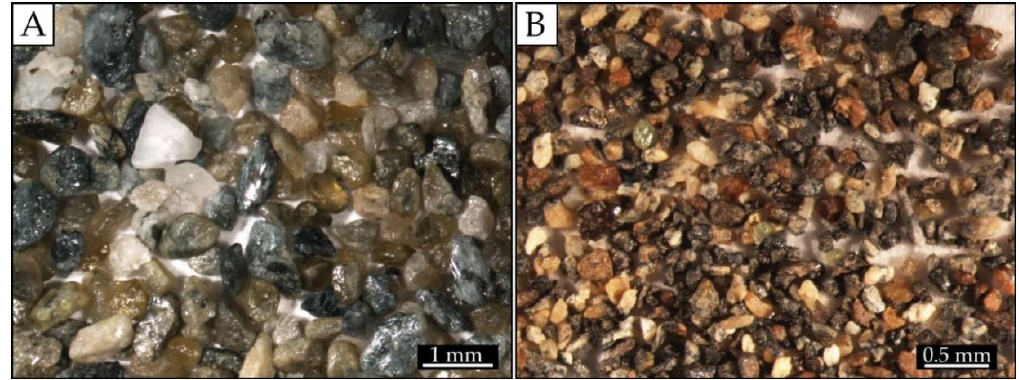
Figure 2. Stereoscopic microscope images. ( A ) Marine sediments from the Jayapura area. Bulk sample JP49, magnification ×2; ( B ) heavy minerals separated from sample JP07, magnification ×0.8.